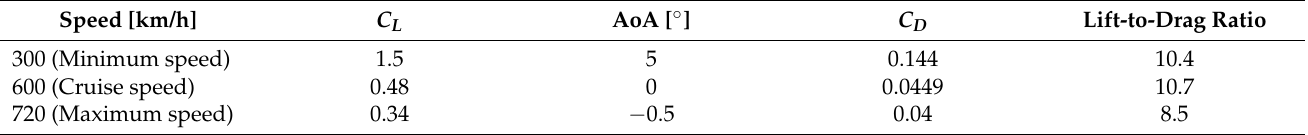
Table 11. Lift-and-drag characteristics at various speeds.